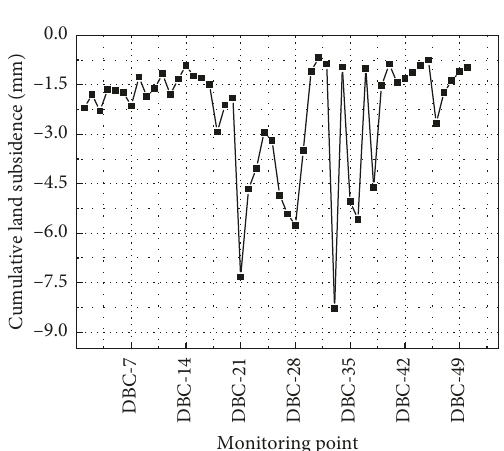
Figure 6: Monitoring value of cumulative land subsidence.